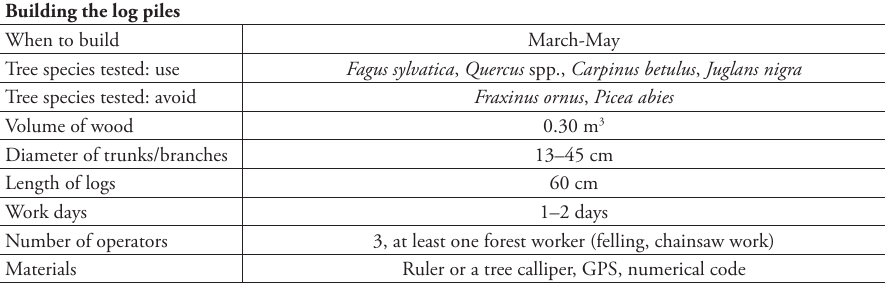
Table 2. Building the wood piles (for details see the